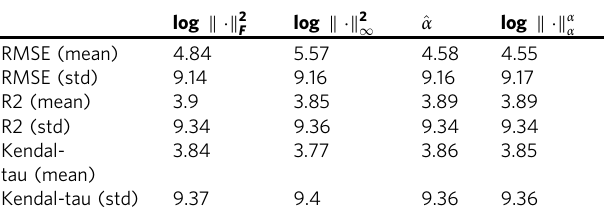
We include regressions only for architectures with fi ve or more data points, and which are positively correlated with test error. These results can be readily reproduced using the Google Colab notebooks. (See Supplementary Note 2 for